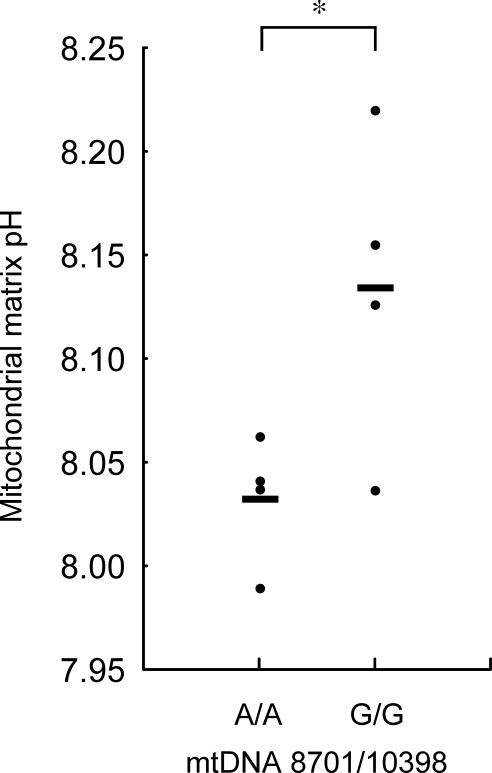
Basal Mitochondrial Matrix pH in the Cybrids with 8701A/10398A or 8701G/10398G
Data from 11–18 cells in a triplicate experiment were averaged for each of four cell lines in each group. The y axis shows mitochondrial matrix pH calculated by calibration in vivo. Horizontal bars indicate the mean values for each type of cybrid. *p < 0.05 (t test).